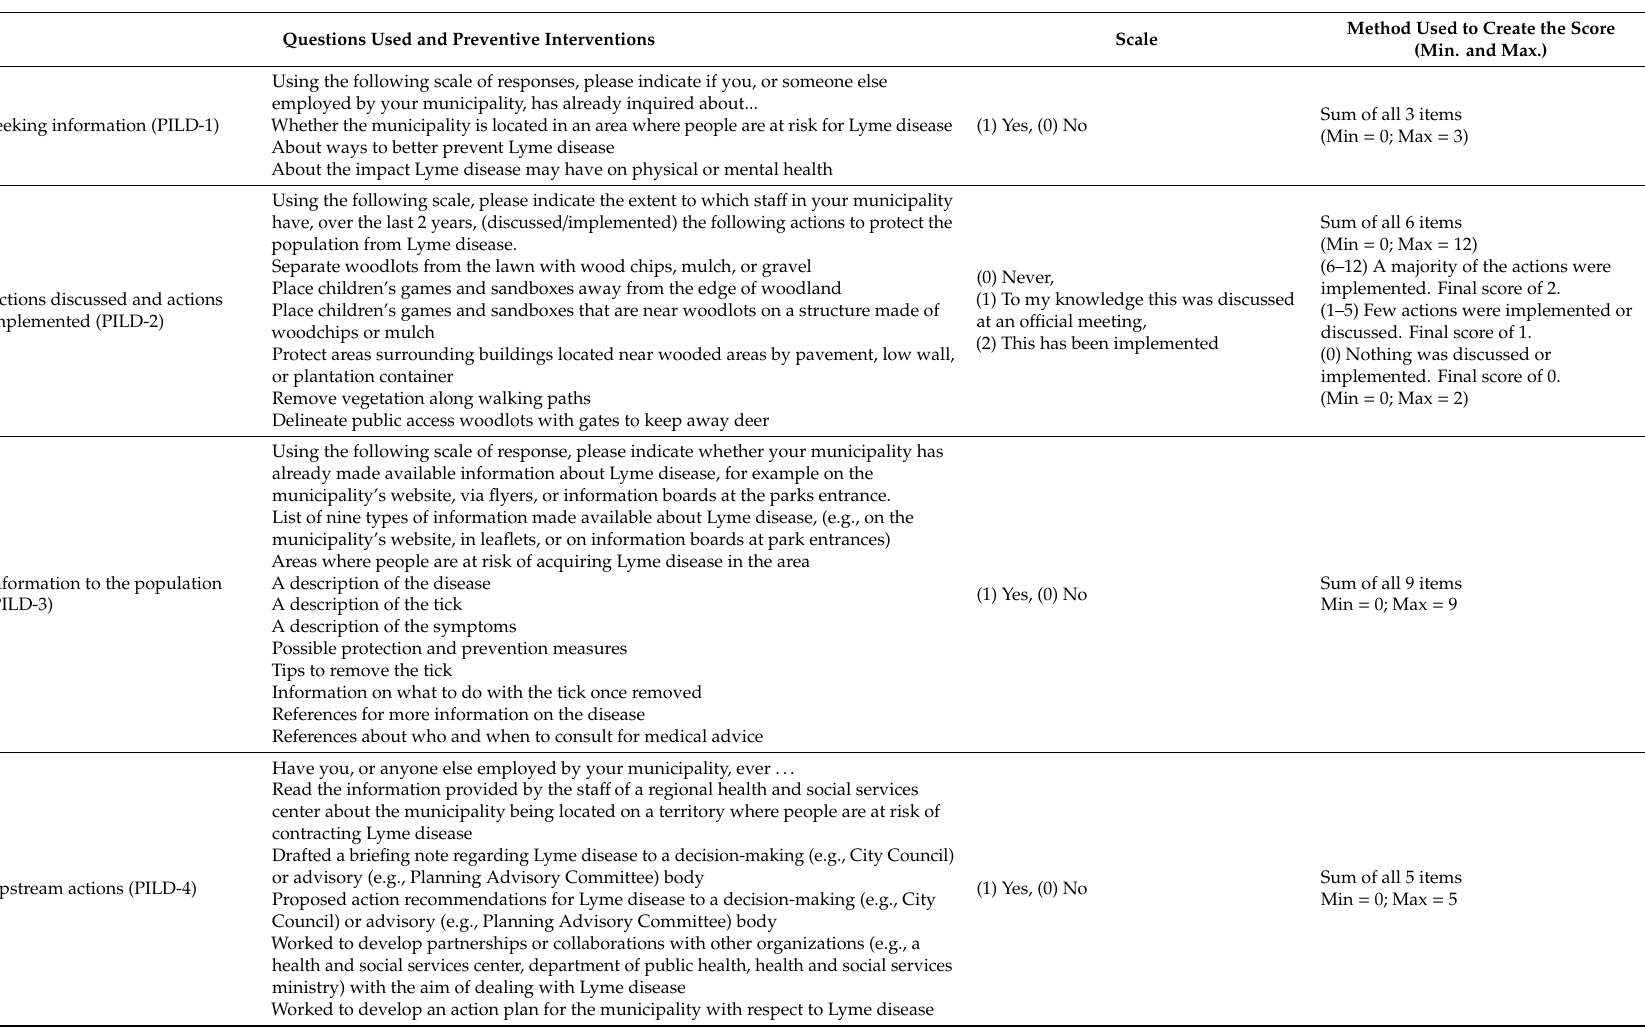
Table 3. Implementation of preventive interventions for Lyme disease measured at the municipal authorities’ level (PILD index). Questions Used and Preventive Interventions Scale